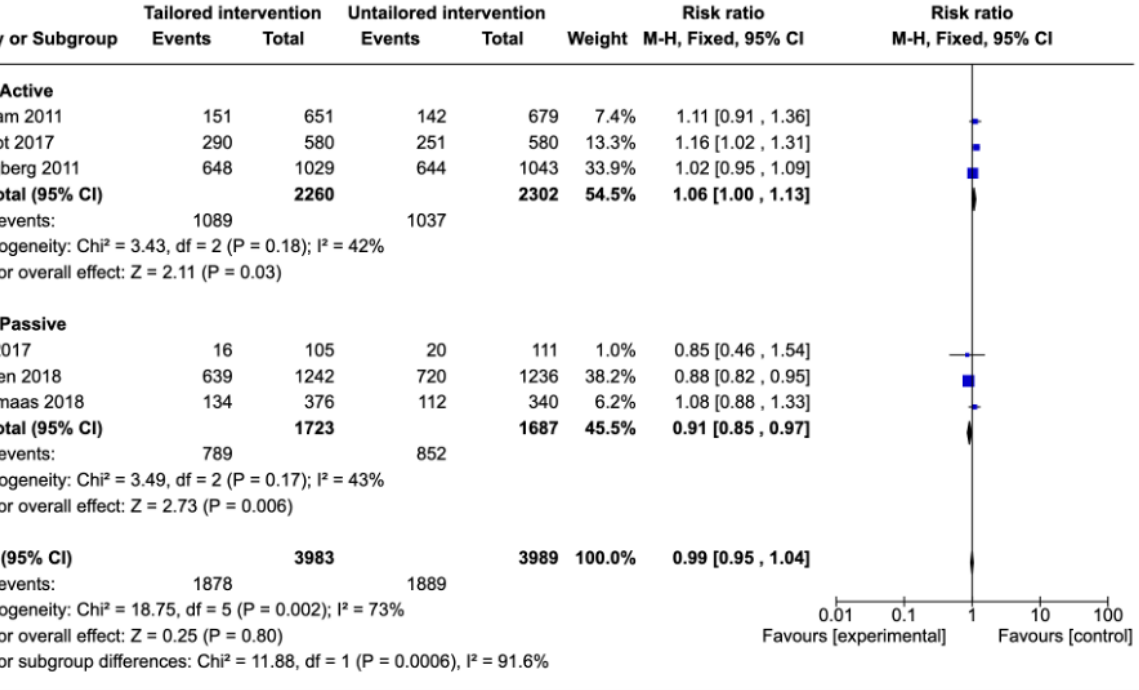
Figure 4. Comparison of attrition between tailored and untailored conditions at 3-month follow-up by control